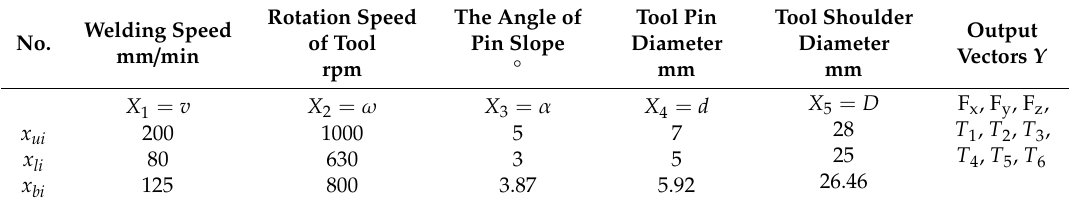
Table 1. Levels of variation of input factors.